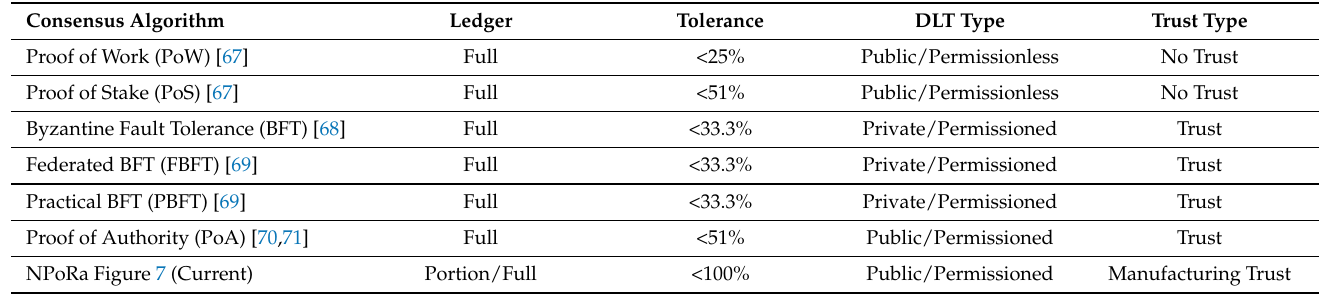
Table 9. A Perspective Comparative of the Proposed Consensus Algorithm with Related Works.